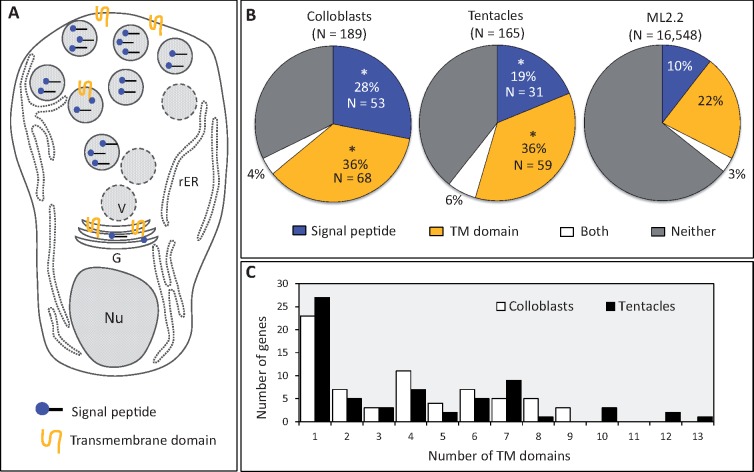
Identification of features associated with subcellular localization. (A) Diagram of an immature colloblast after Storch and Lehnert-Moritz (1974) showing developing secretory vesicles. (B) Both colloblast and tentacle candidates were significantly enriched for genes encoding signal peptides (blue) and transmembrane domains (yellow) (P < 0.0001 for all). (C) Number of genes encoding single- and multi-pass transmembrane domains from colloblast and tentacle candidates.